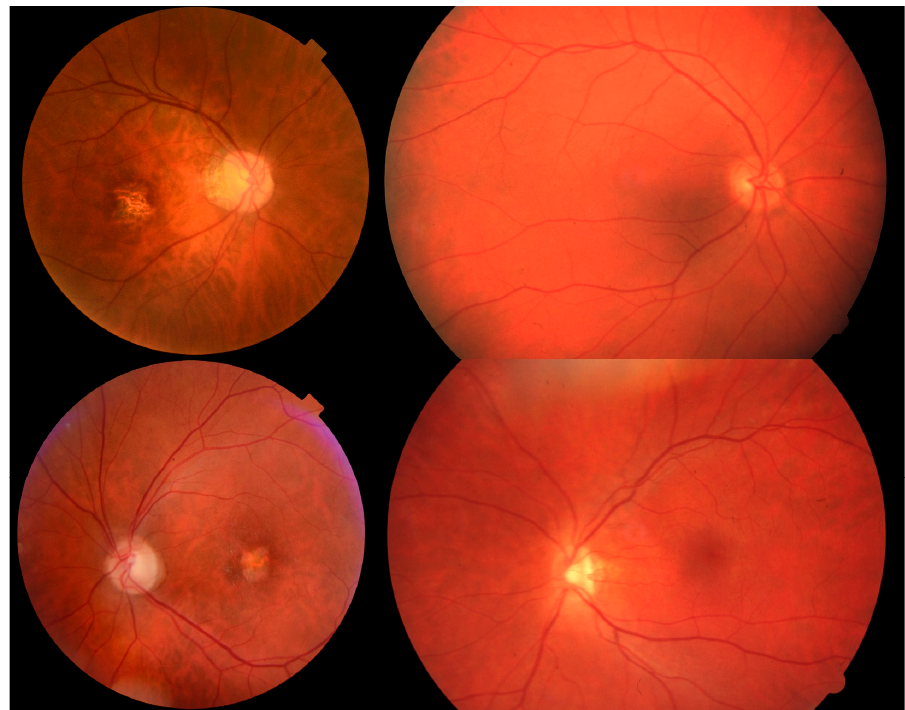
Figure 3. Representative fundus photograph of patients with (left images) and without (right images) central chorioretinal atrophy. The upper panel shows the right eyes of two patients with variants in CNGA3 (c.1641C > A;p.(F54L) homozygous and c.1574G > A;p.(G525D) and c.1694C > T;p.(T565M) respectively) aged 47 and 57 years old, respectively. The lower panel shows the left eyes of two patients both homozygous for c.1148delC in CNGB3 aged 68 and 42 years old, respectively. Refractive data were available for 83 patients; see Figure 4. The median spherical equivalent refractive error (SER) was 0.00 diopters for both eyes (IQR 5.88 for right eye and 5.63 for left